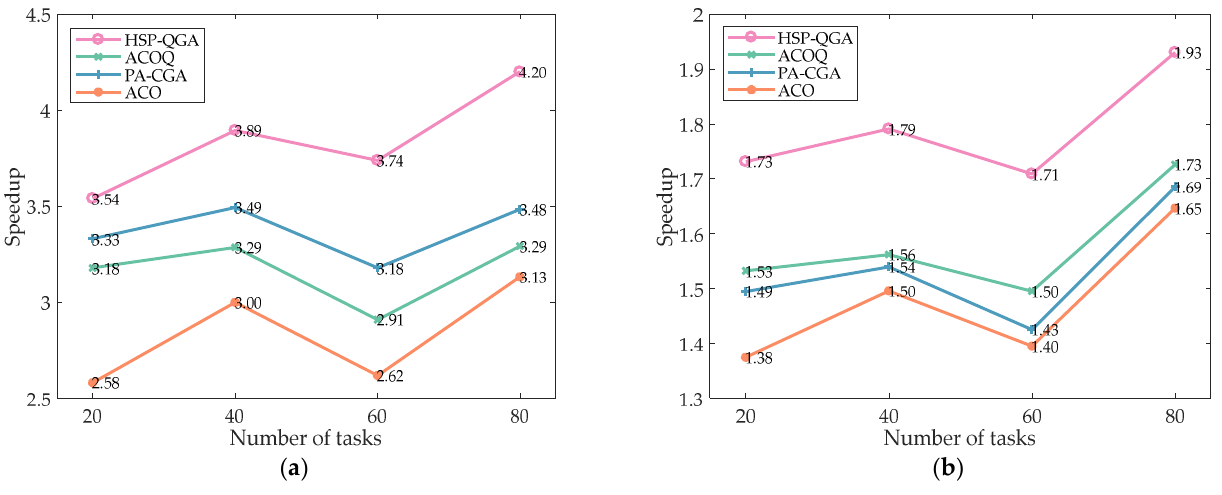
Figure 11. Effect of the number of tasks on speedup: ( a ) CCR = 0.1; ( b ) CCR = 4.